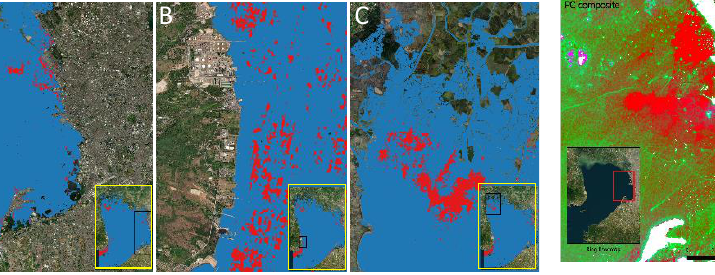
Figure 9. Zoomed in images of the areas in Manila Bay with possible oil slicks. Left is Metro Manila and Cavite; Middle image is Bataan and right image is Pampanga where aquaculture where widespread aquaculture practices exist Bay (Bataan) may indicate small but frequent oil spills. While